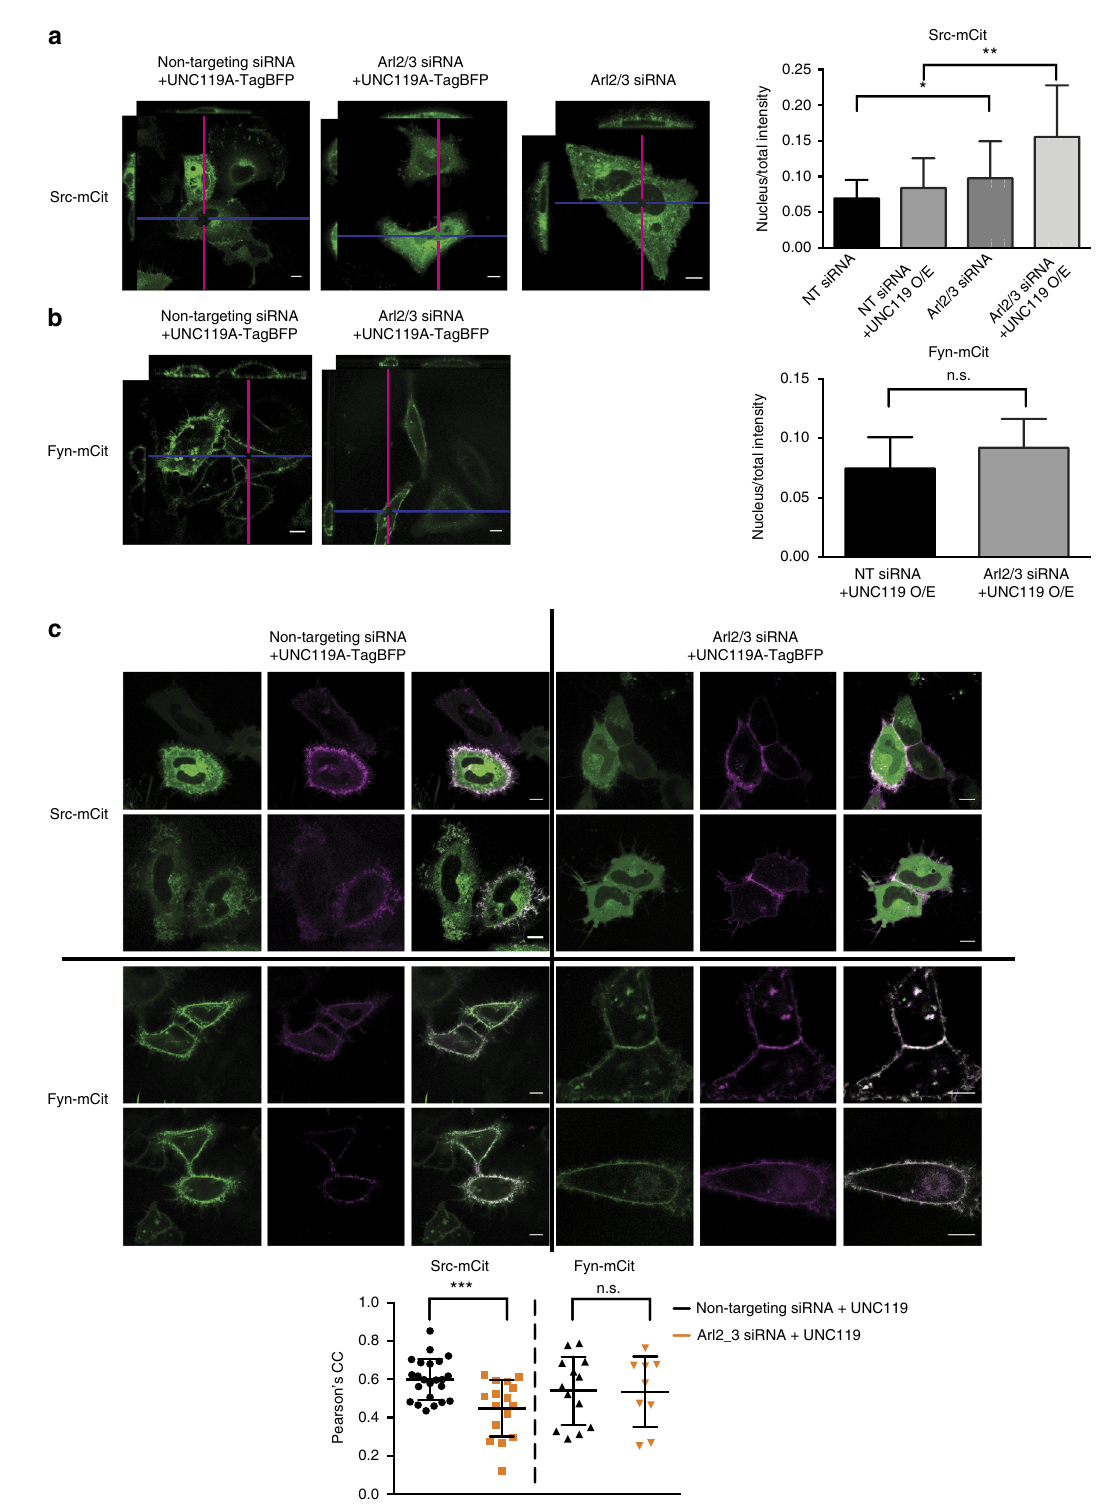
Fig. 5 Arl2/3-mediated allosteric release from UNC119 maintains Src localisation. Confocal Z-stack projections of HeLa cells transfected with Arl2/3- targeting siRNA or non-targeting siRNA control nucleotides (see Supplementary Fig. 6c), ectopically expressing Src-mCit ( a ) or Fyn-mCit ( b ) with or without UNC119A-TagBFP expression. The intersection of the magenta and blue lines indicates the point in the stack that is depicted in the xz and yz planes. Bar graphs show the ratio of nucleus/total integrated fl uorescence intensity for the SFK-mCit channel for each condition ( n = 10 – 20 cells from three independent experiments; data denote mean ± SD; * P < 0.05; ** P < 0.01; n.s., not signi fi cant; Student ’ s t -test). c Confocal micrographs of HeLa cells transfected with Arl2/3-targeting siRNA or non-targeting siRNA control nucleotides, ectopically co-expressing Src-mCit or Fyn-mCit ( green ) and the PM marker mCh-tk-Ras (shown in magenta ). Dot plot depicts the Pearson ’ s correlation coef fi cient between SFK-mCit and mCh-tk-Ras ( n = 23 or 16 cells for Src-mCit and n = 13 or nine cells for Fyn-mCit; data are mean ± SD from three independent experiments; *** P < 0.001; Student ’ s t -test). Scale bars , 10 μ